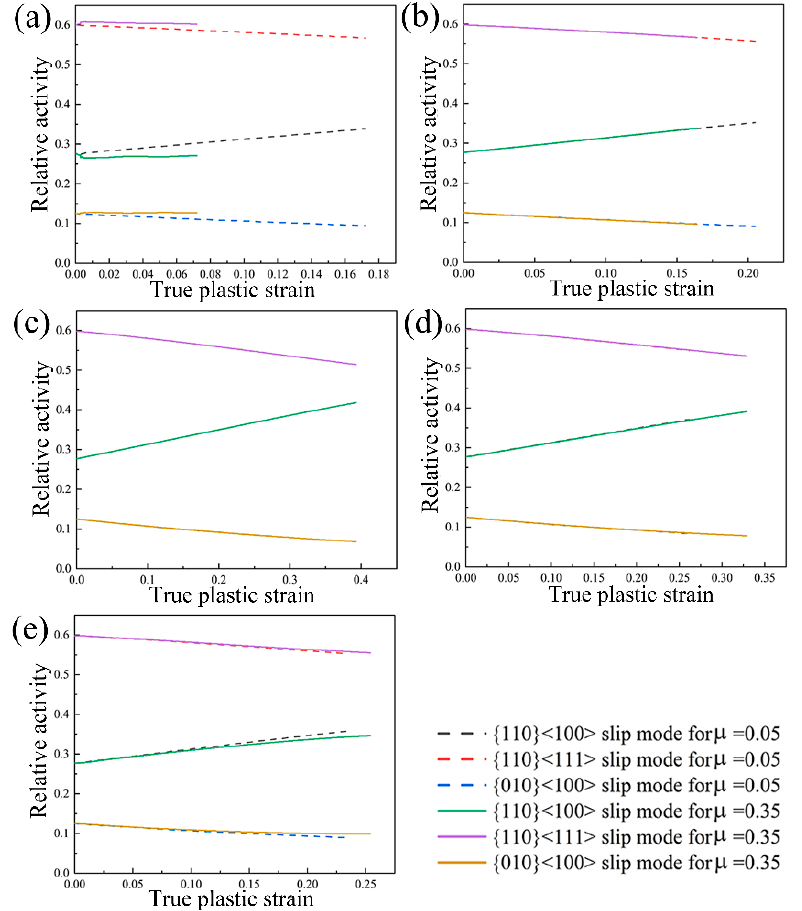
Figure 10. Predicted slip mode activities in the case of friction coefficient of 0.05 and 0.35 during uniaxial compression at the deformation degree of 20%: ( a ) In No. 6338 element; ( b ) In No. 5551 element; ( c ) In No. 3598 element; ( d ) In No. 3555 element; ( e ) In No. 3528 element. (The symbol μ stands for the friction coefficient.).